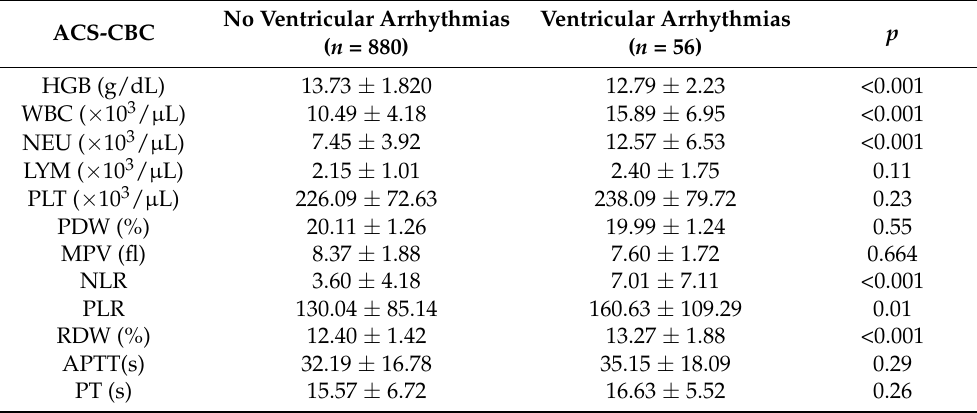
Table 8. Hematological and coagulation parameters of the groups with/without ventricular rhythm disturbances in ACS